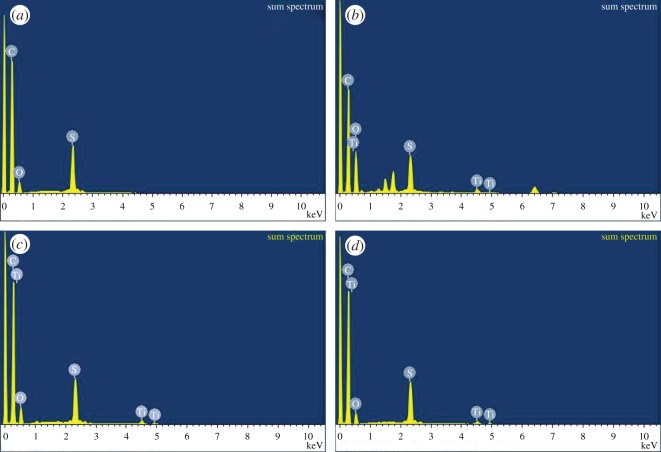
EDX spectra of skin regions of membranes: (a) Control-Psf UF, (b) Psf: 3-nano-TiO2 UF, (c) Psf: FT/3-nano-TiO2 UF and (d) Psf: FC/3-nano-TiO2 UF.